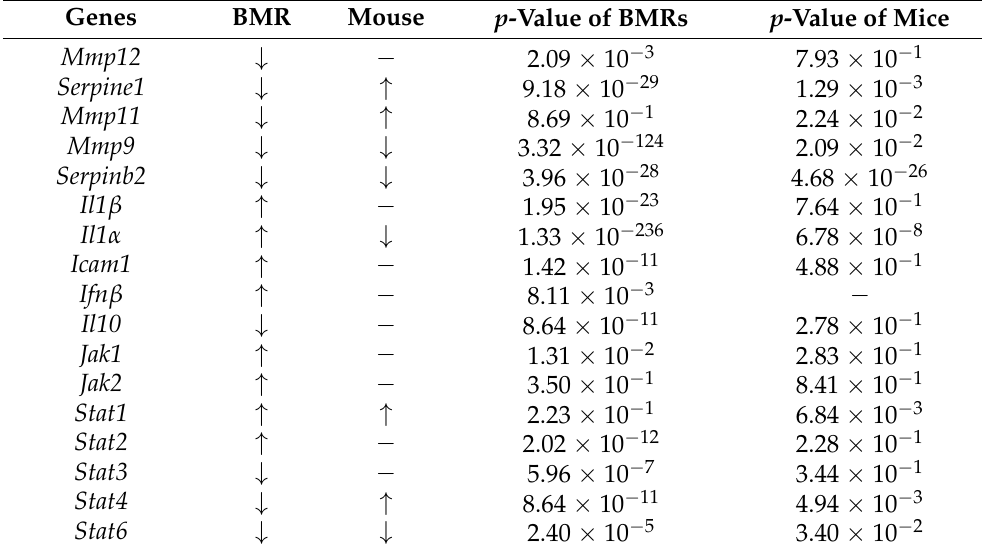
Table 1. Gene list related to cellular senescence/SASP and JAK–STAT signaling in the early and late passages of BMRs and